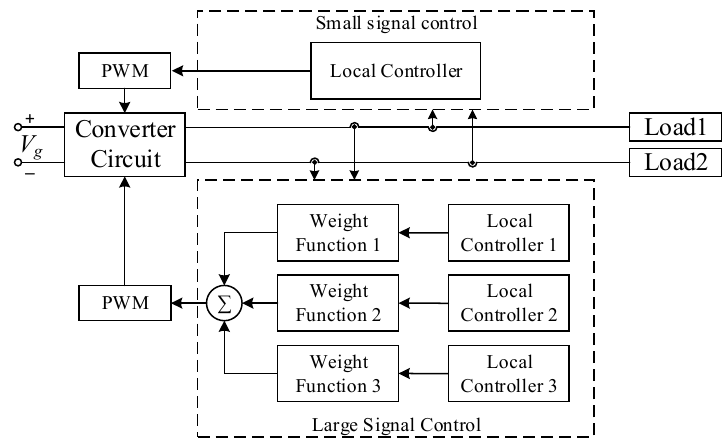
Figure 12. Control strategy.